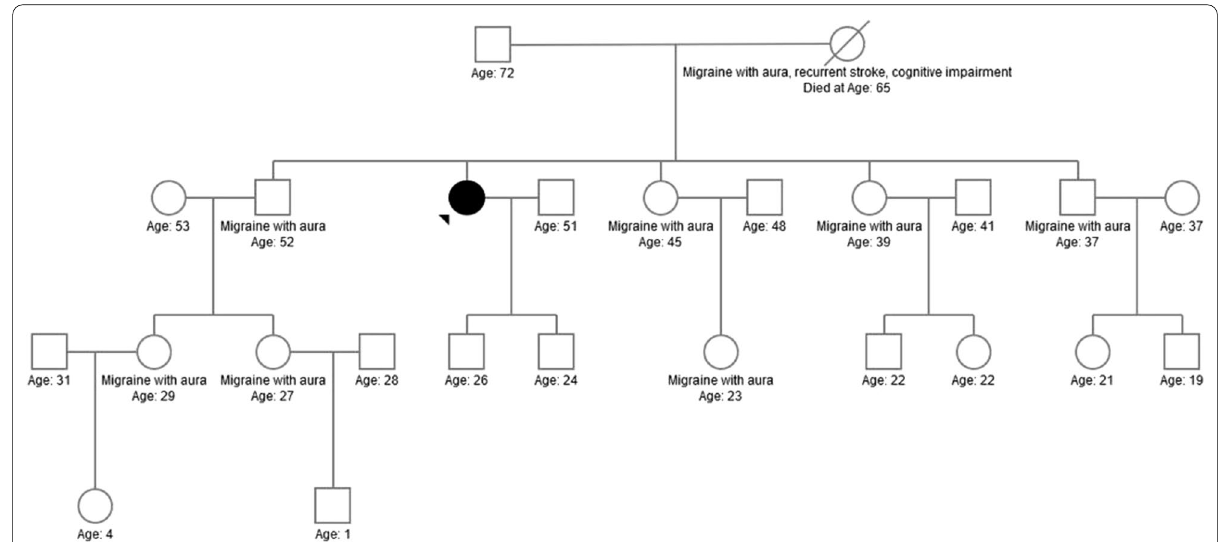
Fig. 1 Pedigree chart of